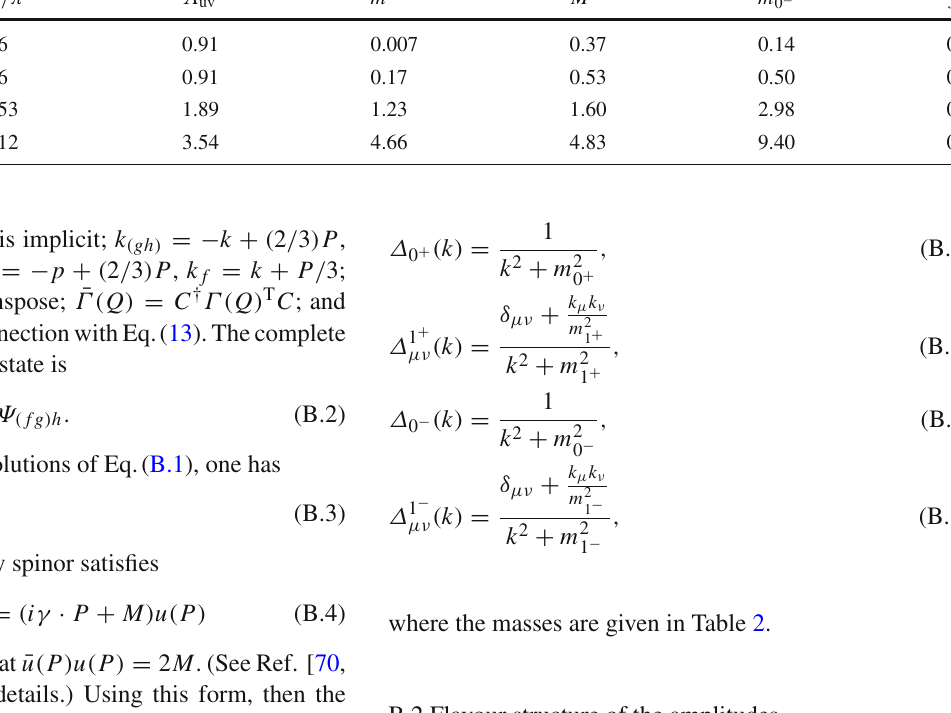
ically, at a sensible level of precision [1]: m π = 0 . 14, f π = 0 . 092; = 2 . 98, f η = 0 . 24; m η = 9 . 40. The m K = 0 . 50, f K = 0 . 11; m η c c b value of f η is discussed in connection with Eq. (A.19). (Dimensioned b quantities in